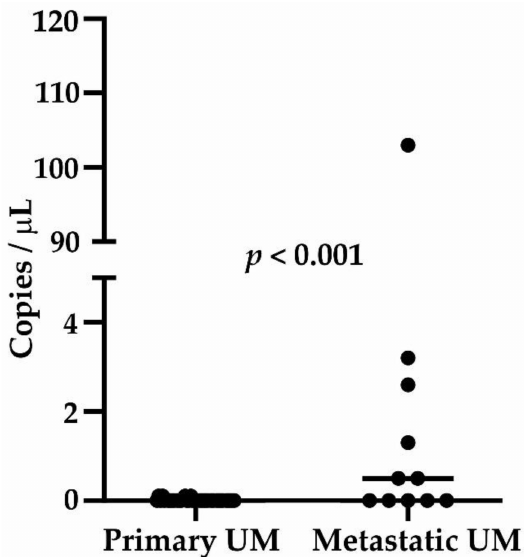
Figure 4. The number of ctDNA copies in µ L of plasma in primary UM and metastatic UM